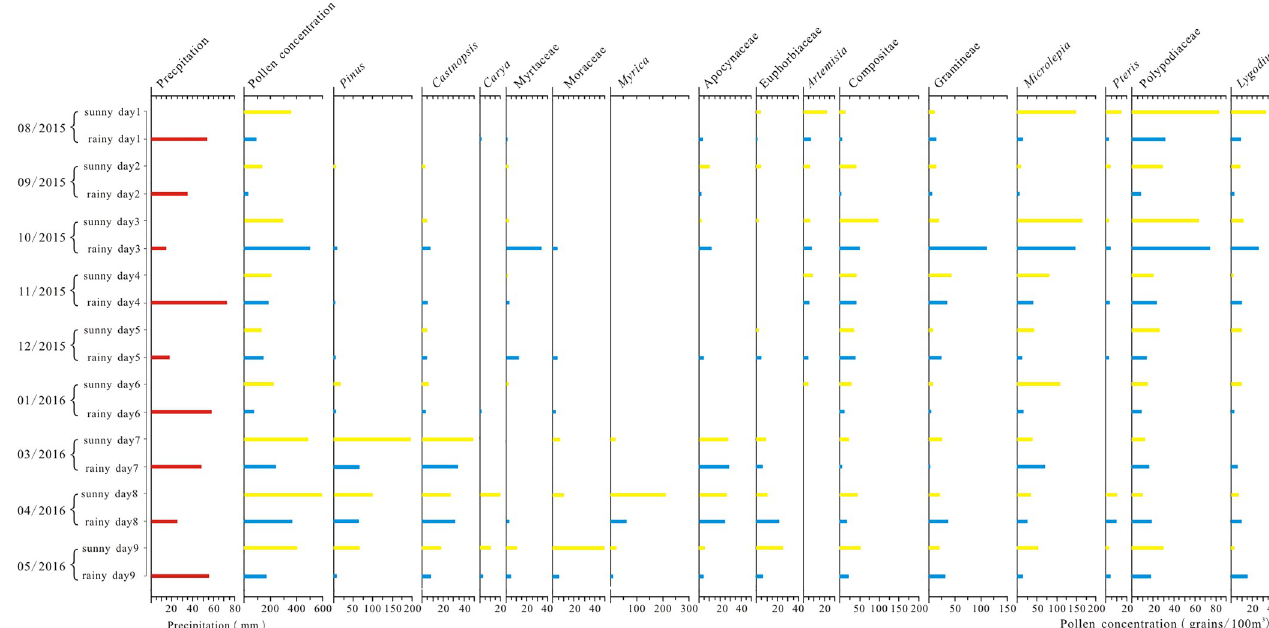
Fig 7. Concentrations of air pollen in periods with sunny days and rainy